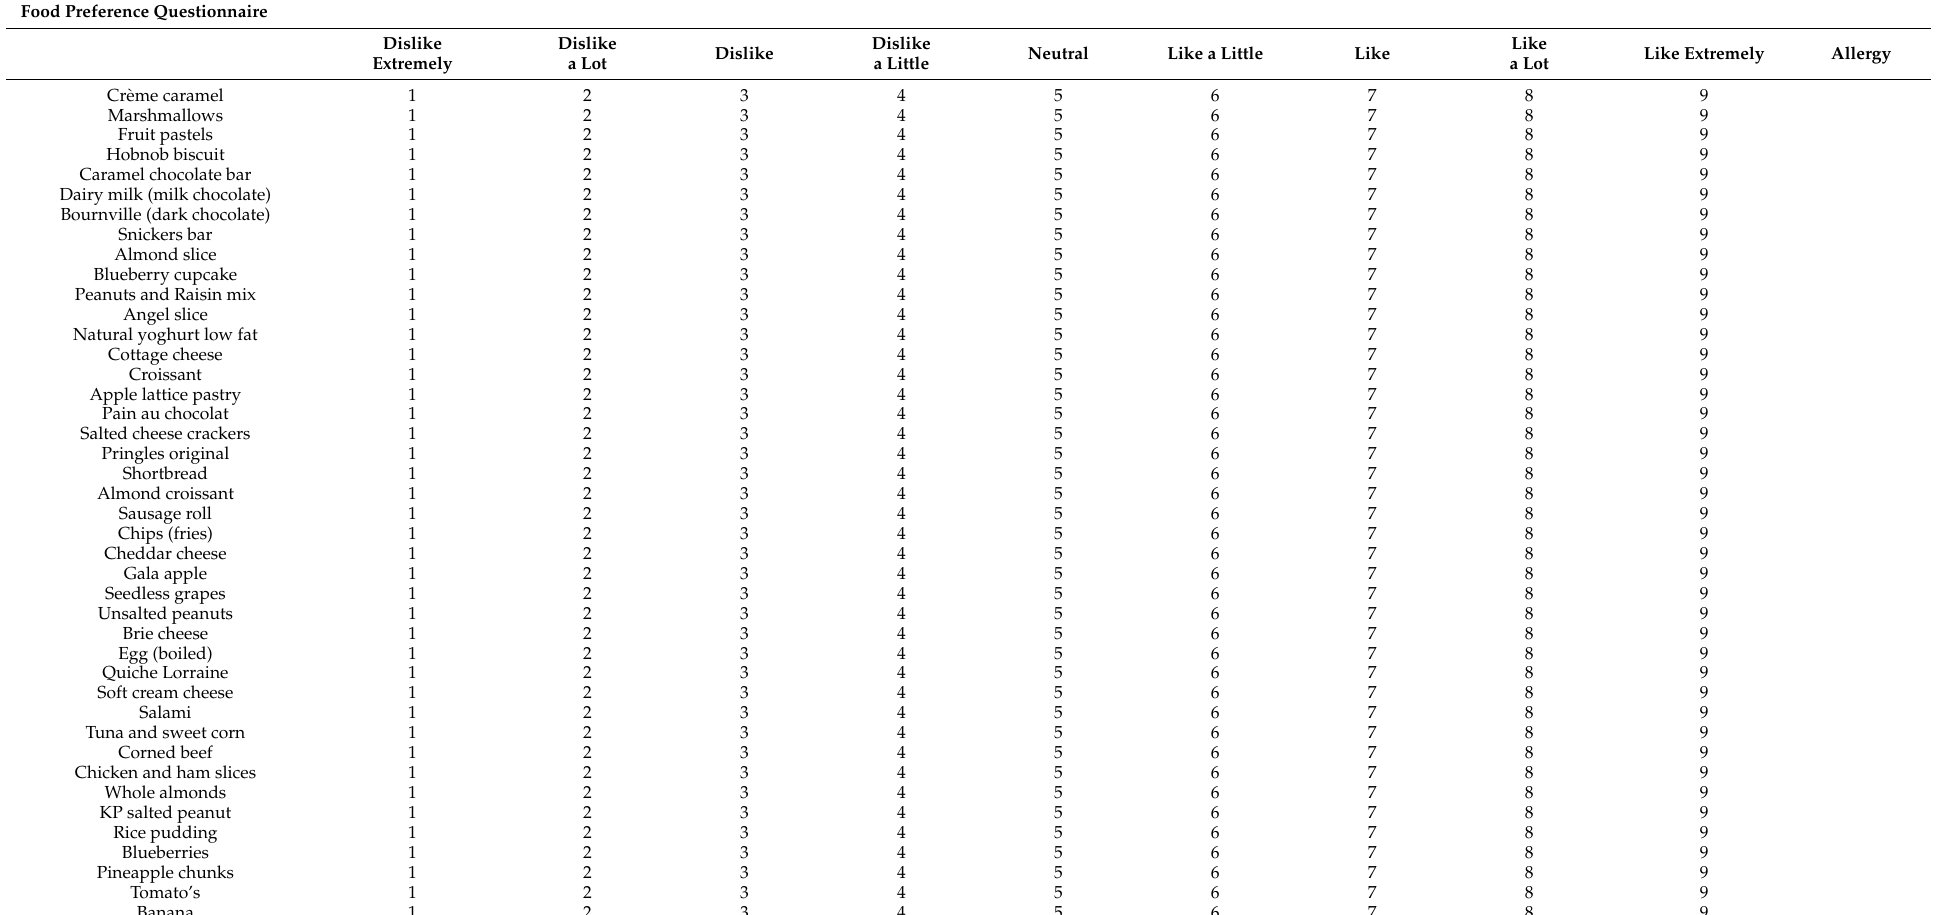
Table A1. Food preference questionnaire. Adapted from Geiselman et al.